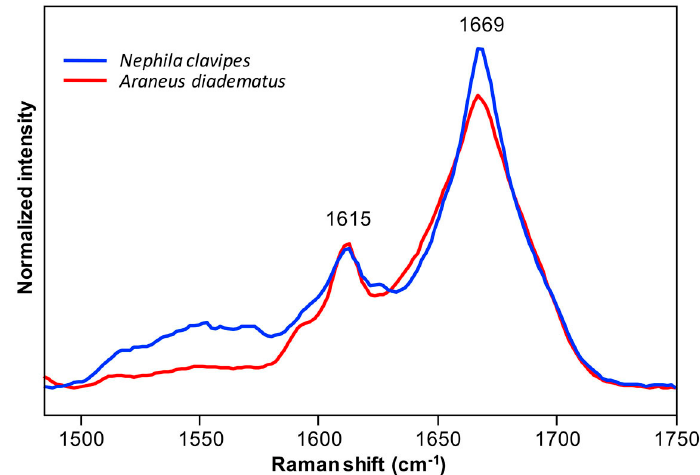
Figure 4. Orientation-insensitive spectra in the amide I region calculated from the average polarized Raman spectra of Nephila clavipes and Araneus diadematus fibers shown in Figure 3 and Figure S1. The spectra are normalized with respect to the total area of the amide I band.